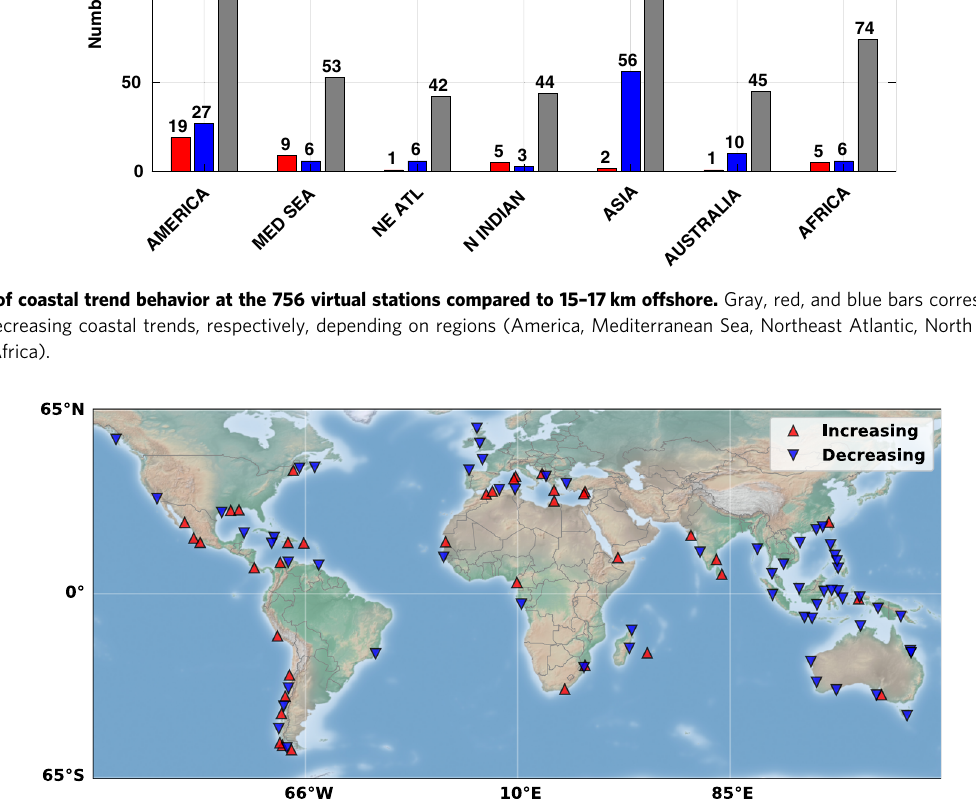
Fig. 7 Virtual stations located at less than 3.5 km from the coast where the coastal trend is different from offshore. Red and blue triangles correspond to increasing and decreasing trends in the last ~4 – 5 km towards the coast compared to offshore (assumed here 15 – 17 km away) (as illustrated by the examples shown in the middle and bottom panels of Fig.